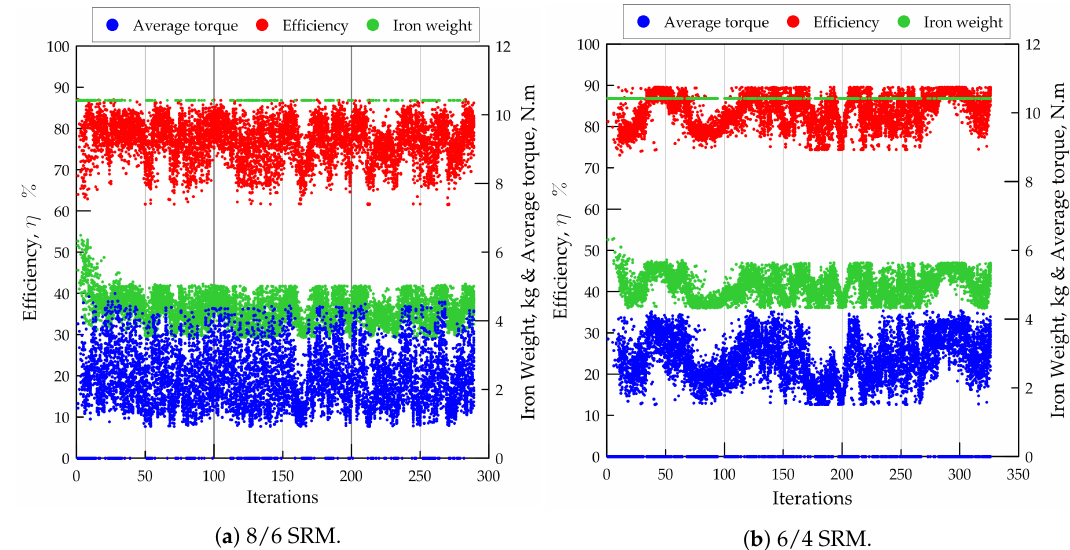
Figure 7. Objectives with iterations for 8/6 and 6/4 SRM using